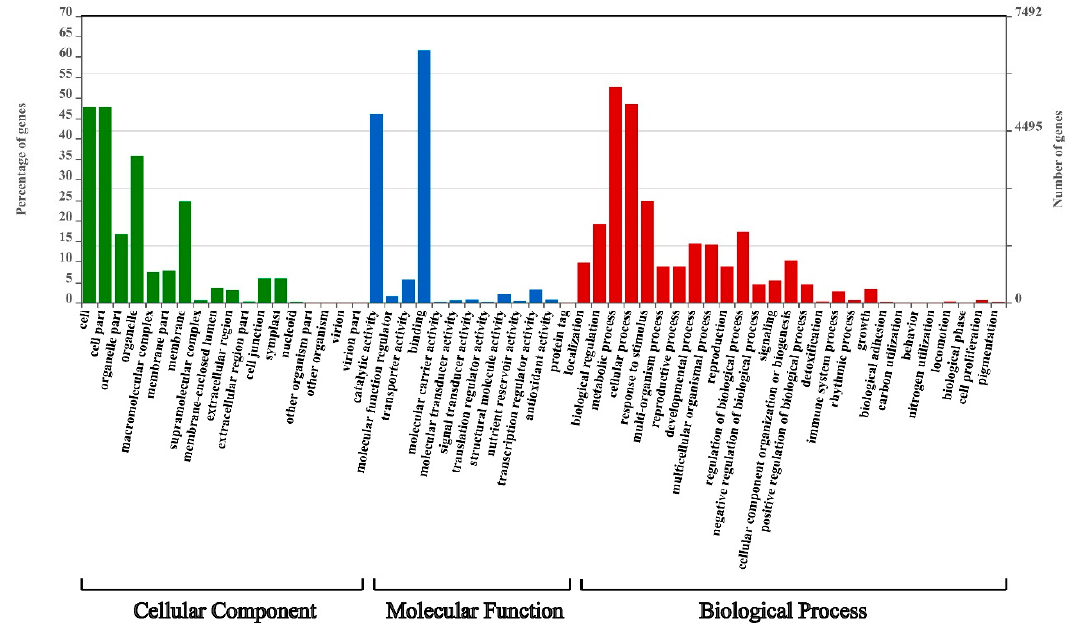
Figure 5. Gene ontology (GO) analysis of CcWRKY target genes. Categories pertaining to cellular components (green color), molecular functions (blue color), and biological processes (red color) were defined by GO classification. Table 2. GO enrichment of the 235 putative CcWRKY target genes involved in the biological processes of response to cold (GO: 0009409).